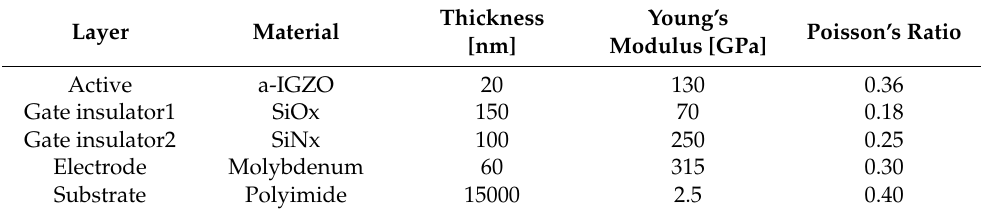
Figure 1. ( a ) Mechanical simulation structure, ( b ) detailed layers, ( c ) structure subjected to perpen- dicular bending with the bending axis vertical relative to the current flow, and ( d ) structure subjected to parallel bending with the bending axis parallel relative to the current flow. Table 1. Intrinsic parameters used in the mechanical simulation.